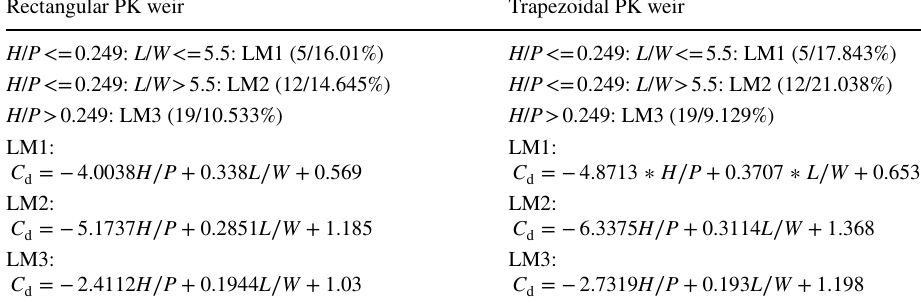
Table 4 Linear equations of M5 model